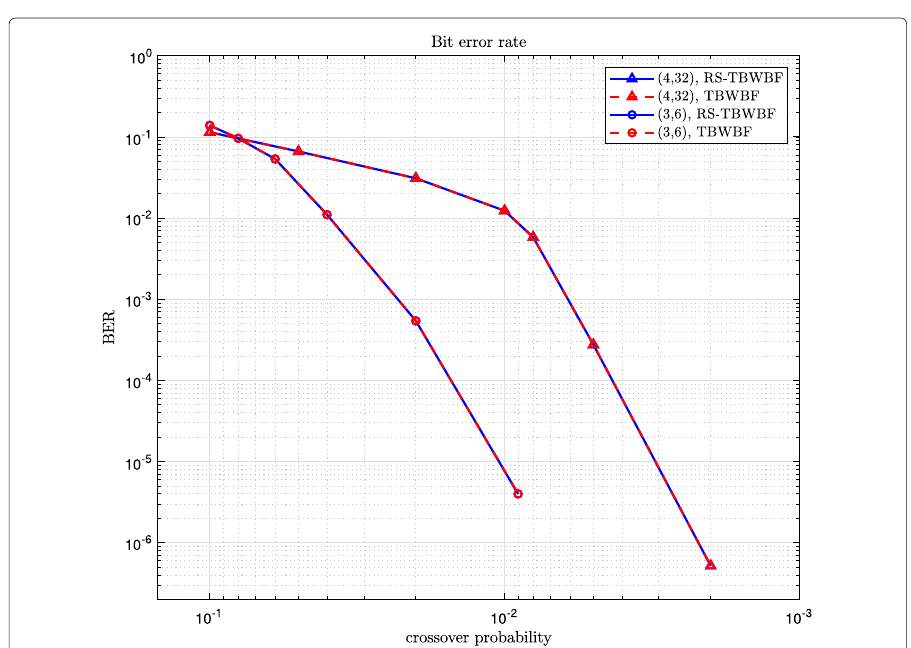
Fig. 9 Performance of regular LDPC codes with rate 1